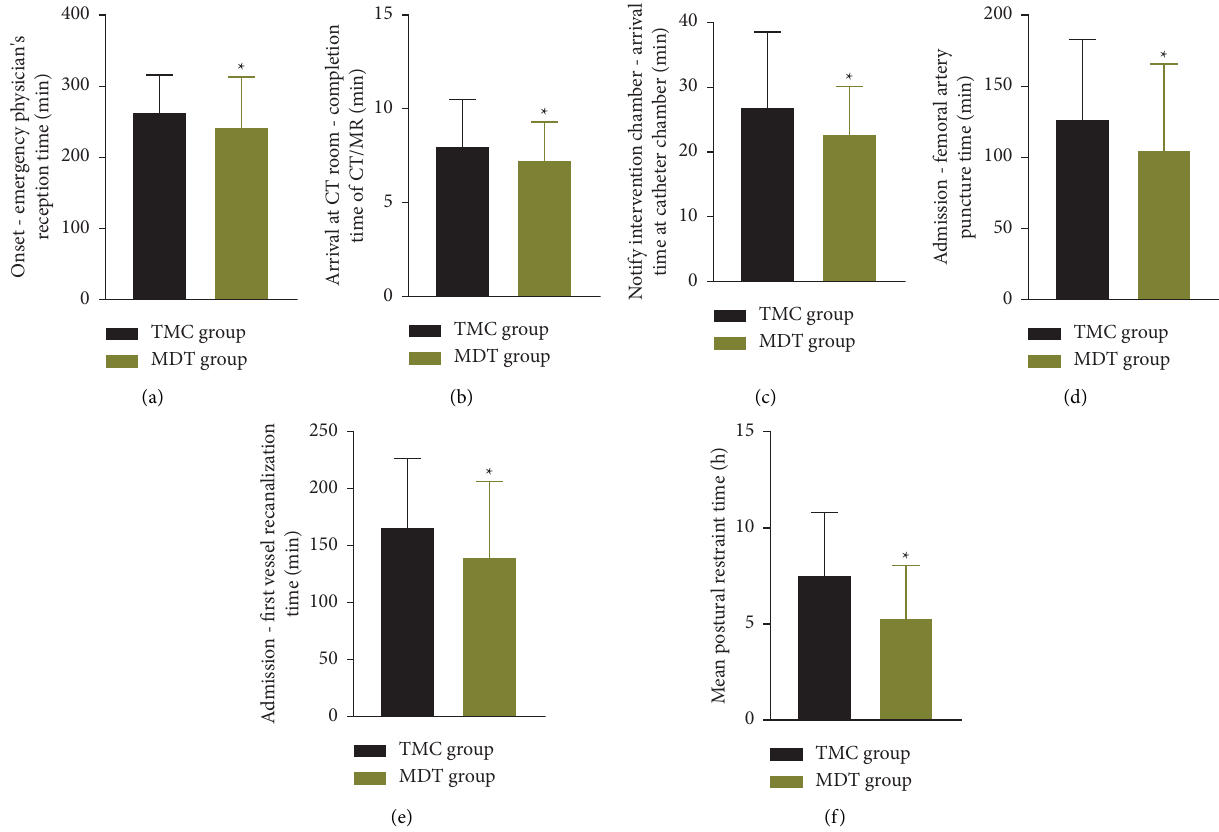
Figure 2: Perioperative time indicators. Note: (a) Onset—emergency physician’s reception time (min), (b) arrival at CTroom—completion time of CT/MR (min), (c) notify intervention chamber—arrival time at catheter chamber (min), (d) admission—femoral artery puncture time (min), (e) admission—frst vessel recanalization time (min), (f) mean postural restraint time (h). comparison of same time indicators between groups, ∗ P < 0 .